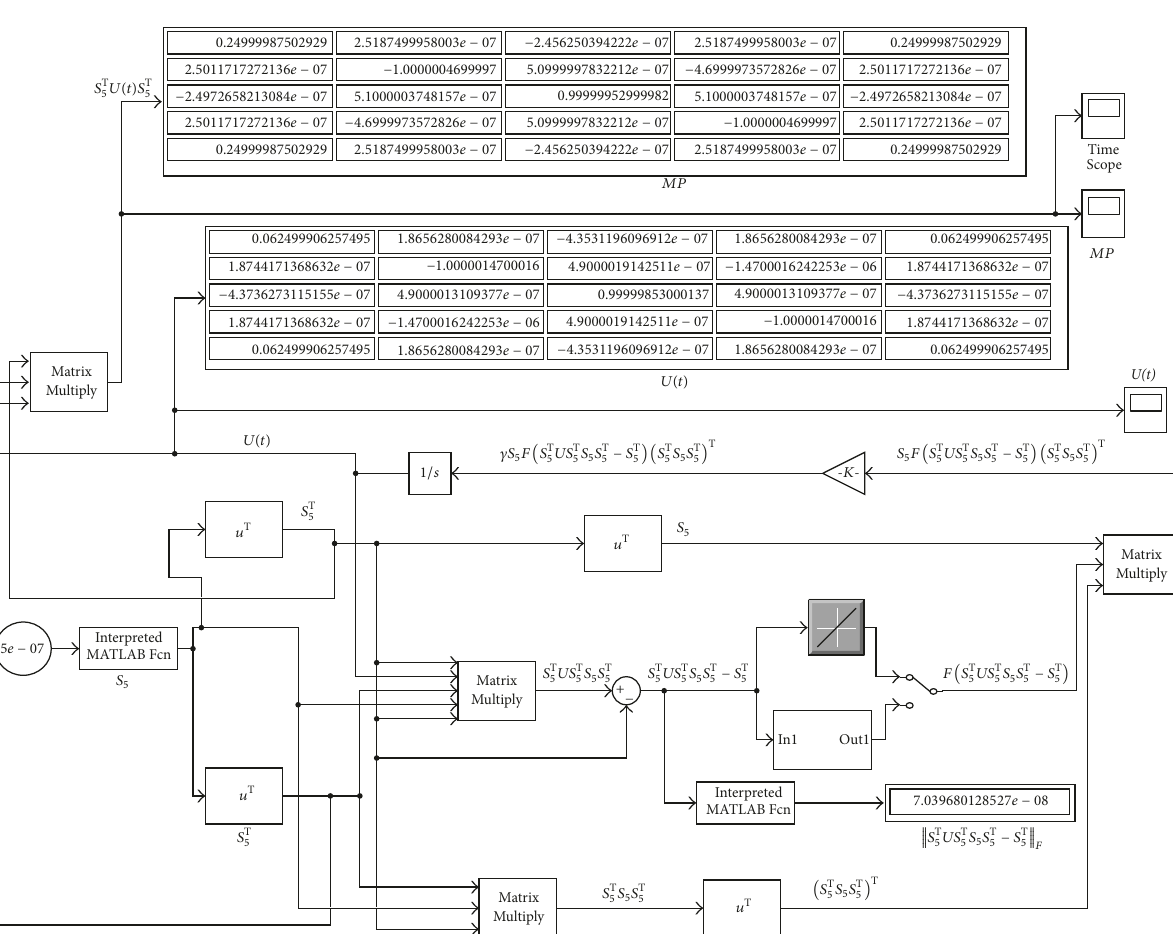
Figure 10: The Simulink adopted for computation of 𝑆 5 (𝑡) † .